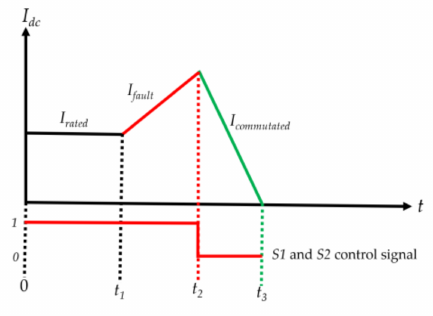
Figure 13. Fault current handling